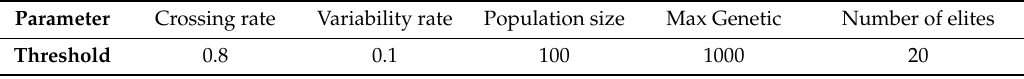
Table 1. The parameters and threshold setting of the genetic